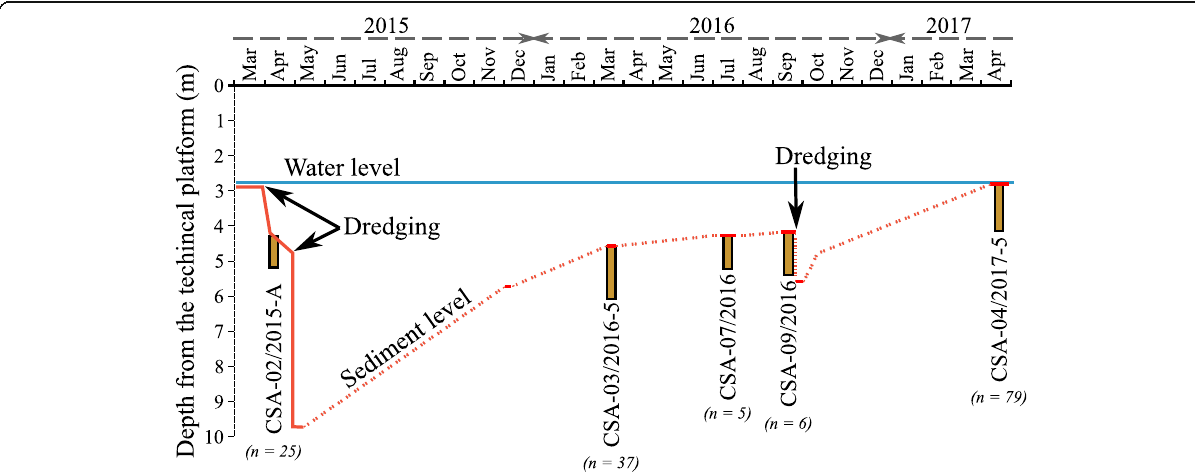
Fig. 1 Evolution of the water level and the sediment level during the sampling, with the label used hereafter for each core. Numbers in brackets correspond to the number of samples analyzed for DTR contents per